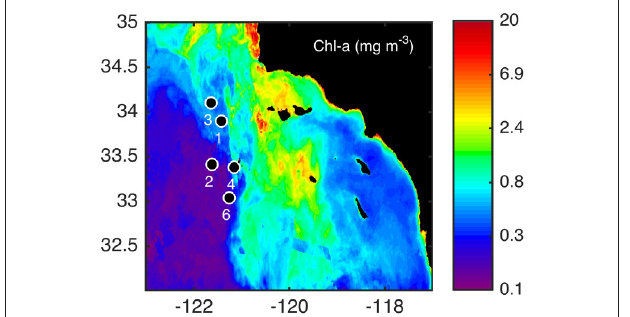
FIGURE 1 | Sampling locations for water column profiles and incubation experiments during the June/July 2011 cruise. Stations were sampled in the coastal (3, 4), frontal (1, 6), and oceanic (2) side of a distinct frontal feature (Brzezinski et al., 2015; Krause et al., 2015) shown over the averaged chlorophyll a (chl-a;mg m − 3 ) for the month of July in